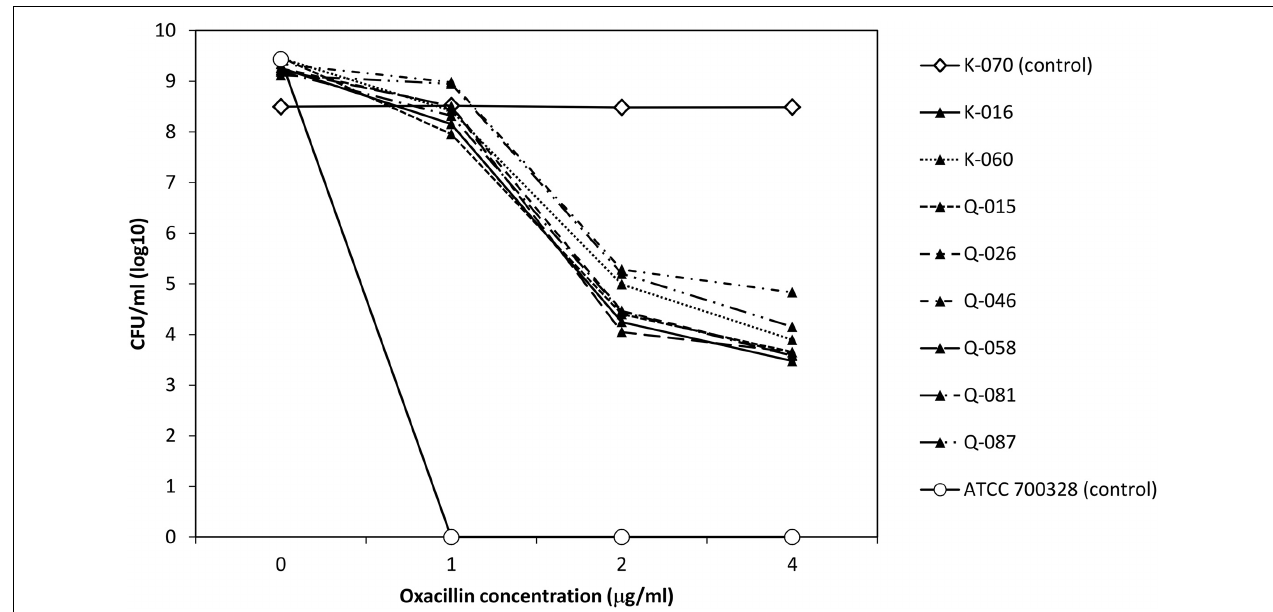
FIGURE 3 | Analysis of oxacillin-resistant subpopulations of 8 cefoxitin DD-susceptible/ mecA -positive strains and two control strains.